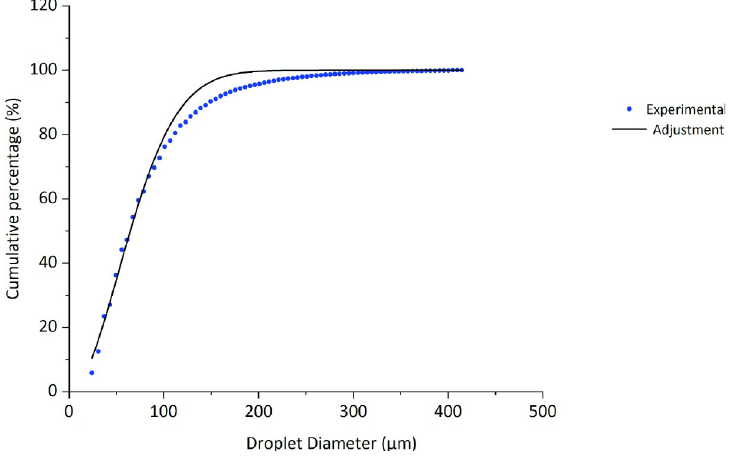
Fig 8. Rosin–Rammler distribution function for the data collected from the WSPs.